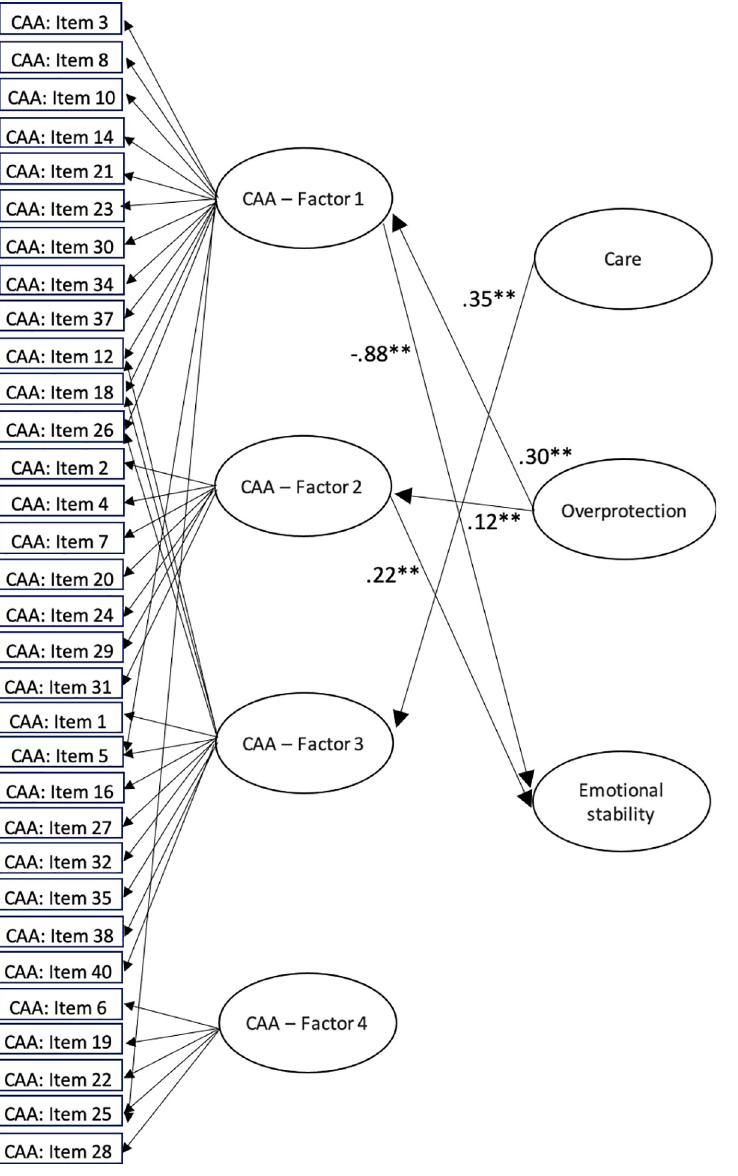
Fig 2. Structural equation model for the normal-range attachment group. differ between the two groups, and this is the final piece of information derived from the struc- tural model. As in the FMA analysis, the means on the external variables were set to zero in the largest, undifferentiated group, and freely estimated in the insecure attachment group, here with the restriction that the pooled variance in both groups is 1. The results are in Table 5 and are all significant at the conventional .05 level (standard errors are in the order of 0.04 in all cases). Furthermore, given the scaling we used, the mean estimates in the insecure attachment group are also Cohen’s d effect sizes for the difference of means. Under the usual standards for d , they would qualify as small or medium. According to the results, the insecure attachment group has lower scores for Emotional stability and Care, and higher scores for Overprotection than the normal-range group.